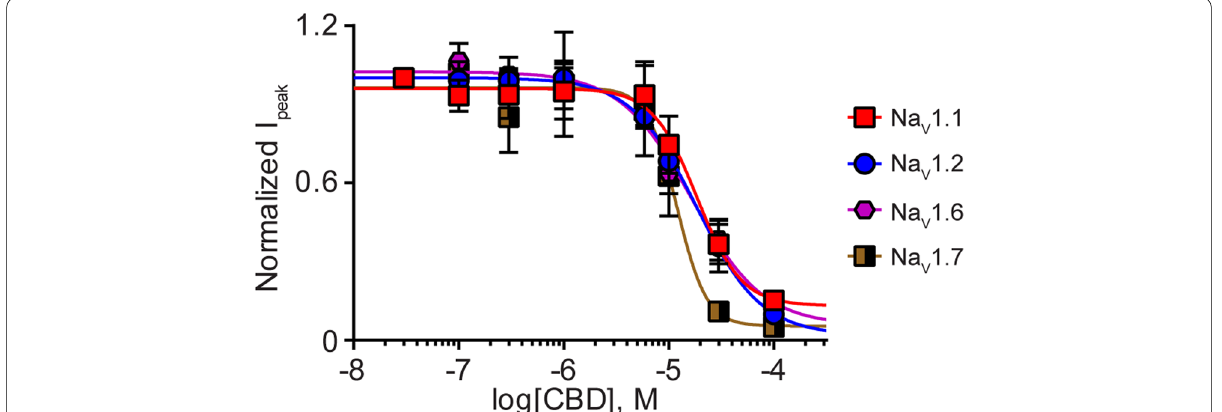
values for NP on Na 50 of CBD found in NP 50